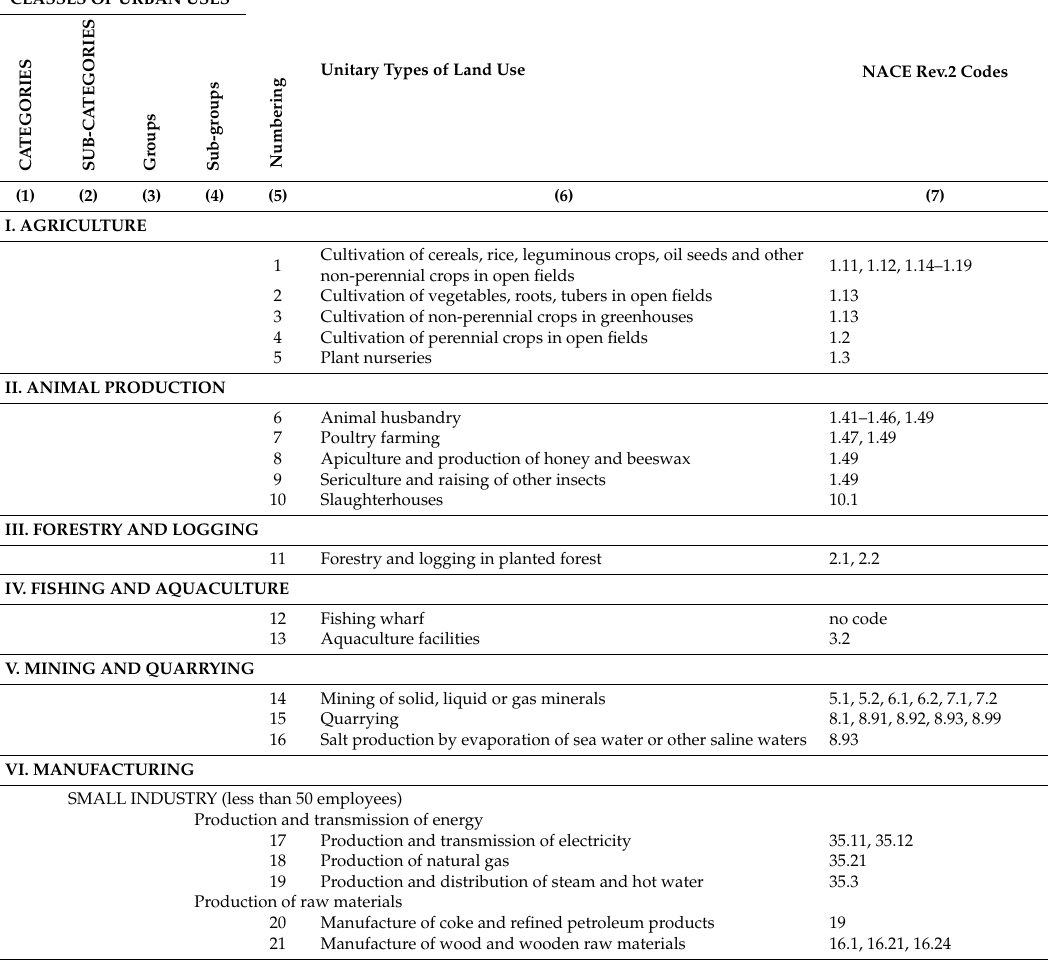
Table A1. Classification of the unitary types of urban uses into categories, sub-categories, groups and sub-groups (columns 1, 2, 3 and 4 respectively), on the basis of purely urbanological criteria. Columns 5 and 6 give our numbering and description of each type of use, and Column 7 the code numbers of the unitary types of urban planning according to NACE